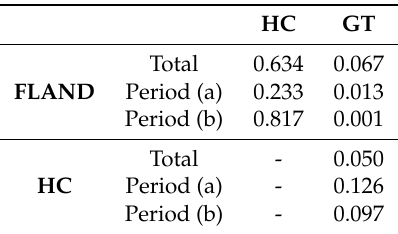
Table 3. Comparison with human coder and gaze trackers: Cohen’s kappa coefficients for the total period, Periods (a) and